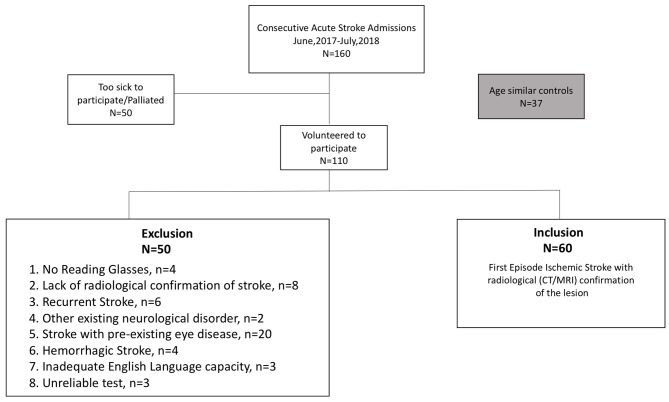
Consort diagram (36).